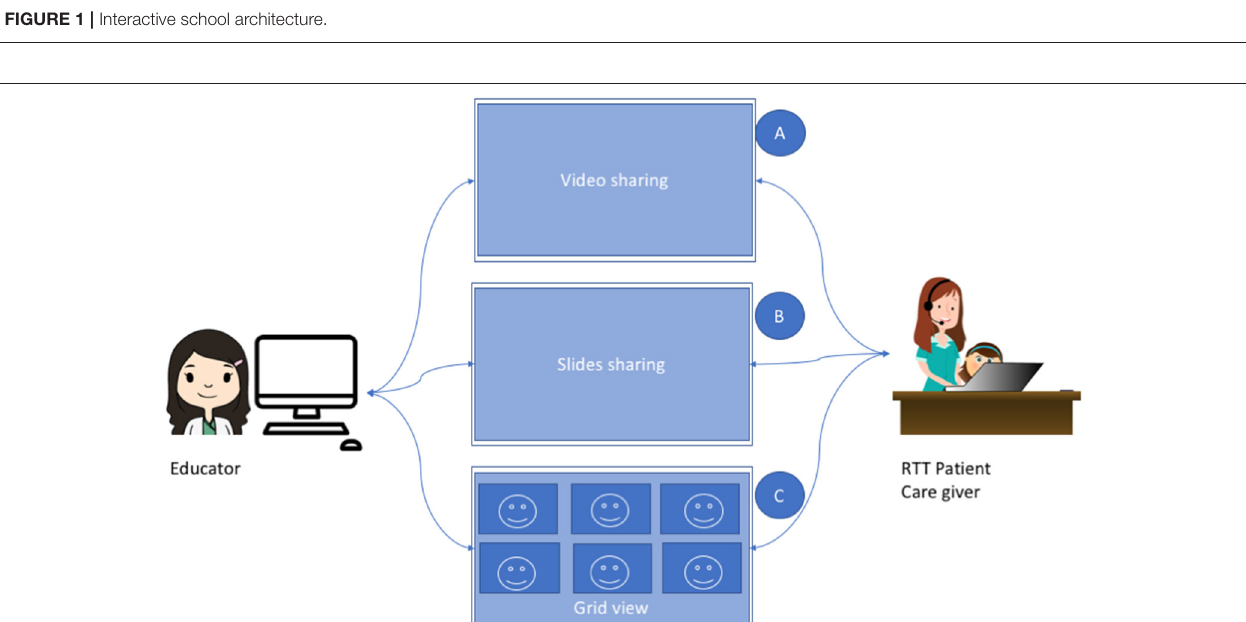
FIGURE 2 | Lesson